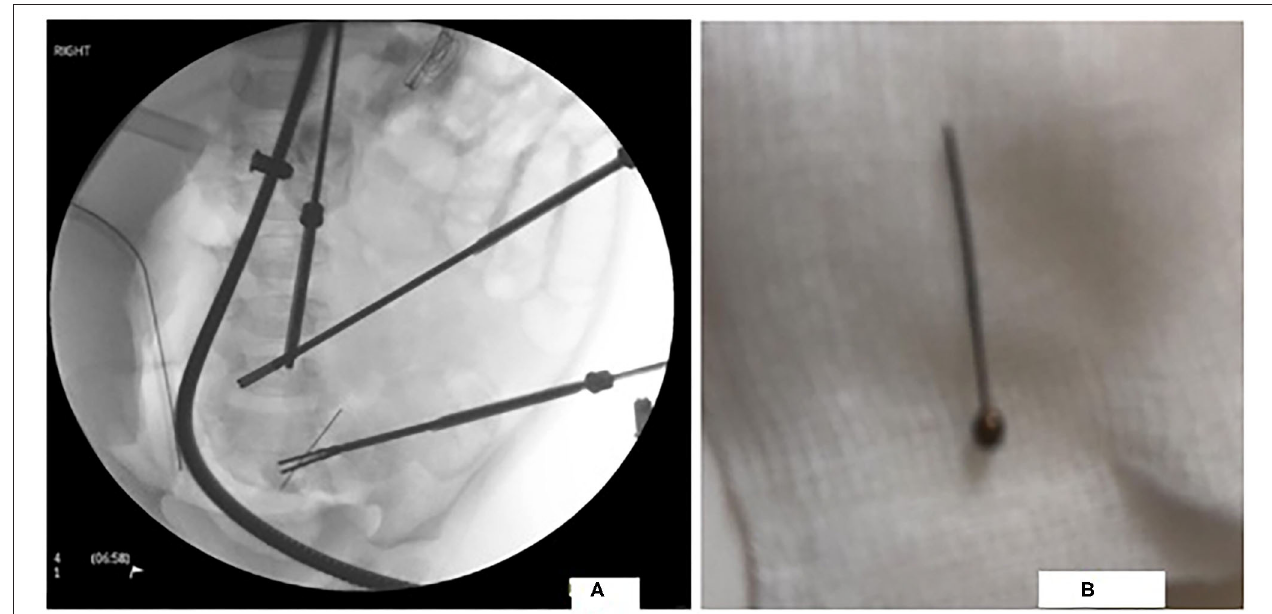
FIGURE 2 | Laparoscopic image of the FB in the distal ileum in figure (A) and a photograph of the extracted FB in figure (B) .